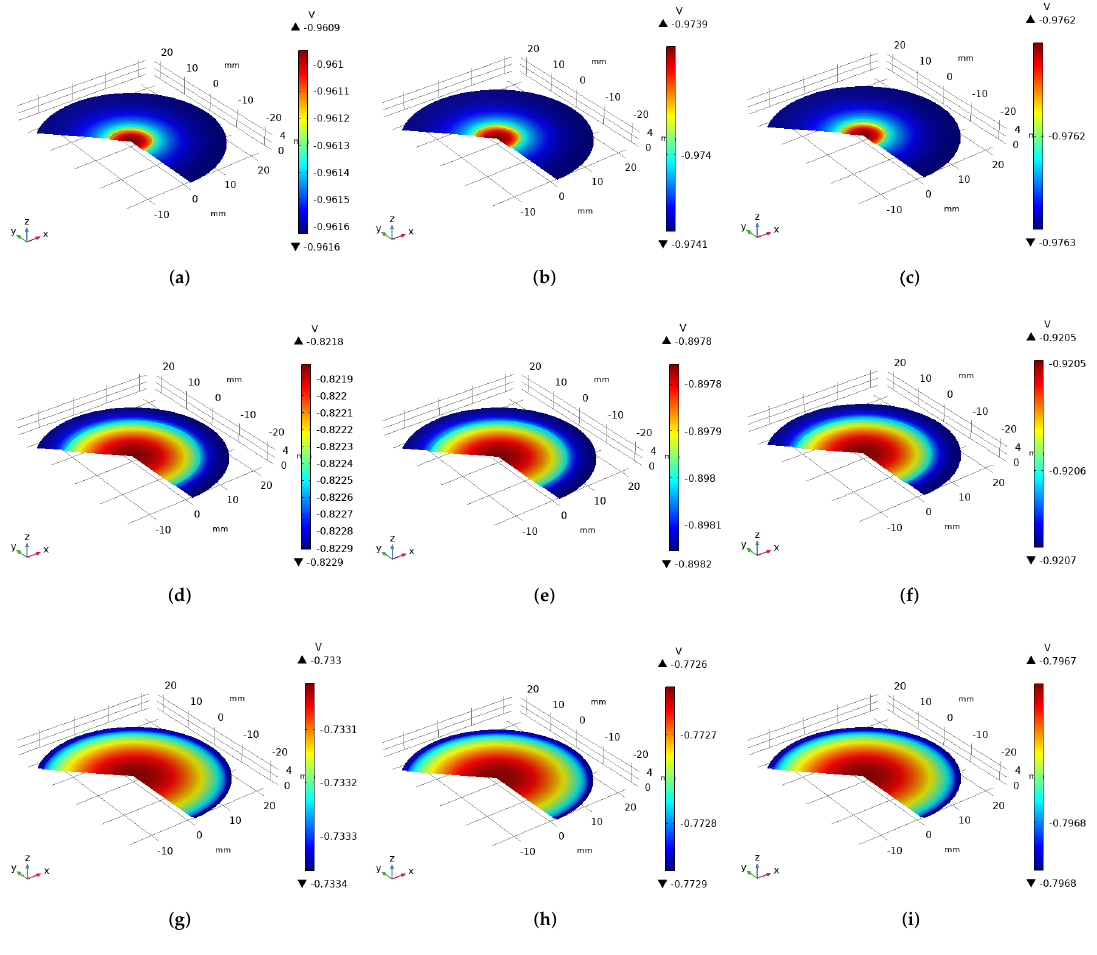
Figure 3. Simulated electrode potential. ( a ) 5% of exposed steel with E0 . ( b ) 5% of exposed steel with E1 . ( c ) 5% of exposed steel with E2 . ( d ) 50% of exposed steel with E0 . ( e ) 50% of exposed steel with E1 . ( f ) 50% of exposed steel with E2 . ( g ) 90% of exposed steel with E0 . ( h ) 90% of exposed steel with E1 . ( i ) 90% of exposed steel with E2